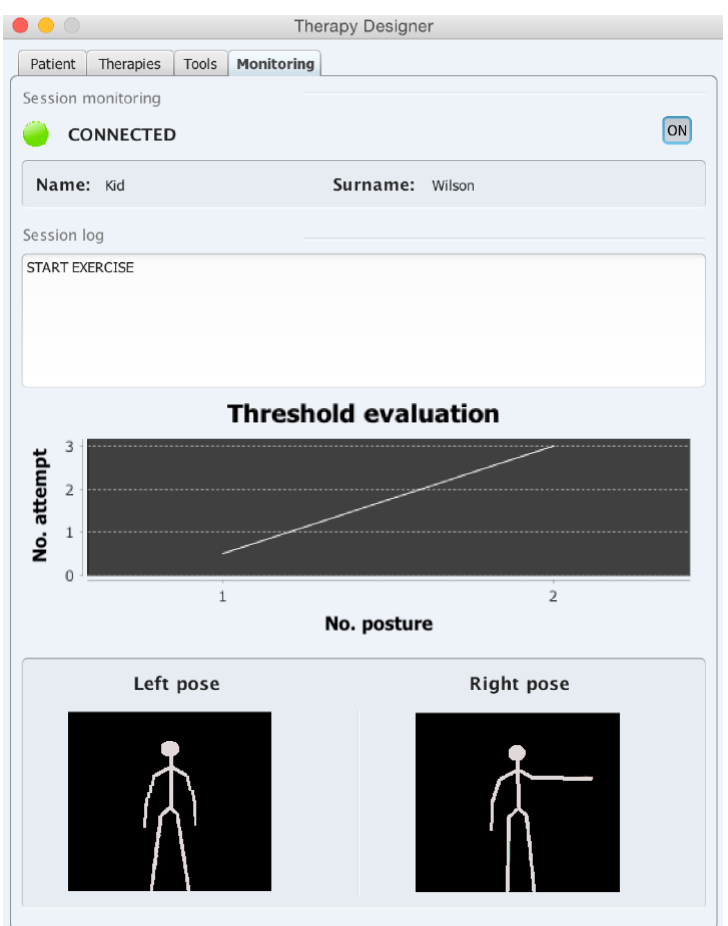
Figure 6. NAOTherapist monitoring interface. Real-time information is offered to the therapist, including the step that is currently being performed during the therapy session, a plot showing the number of attempts that the patient needed to complete each posture (information internally used by the architecture to adjust the evaluation threshold), and finally the last position asked of the